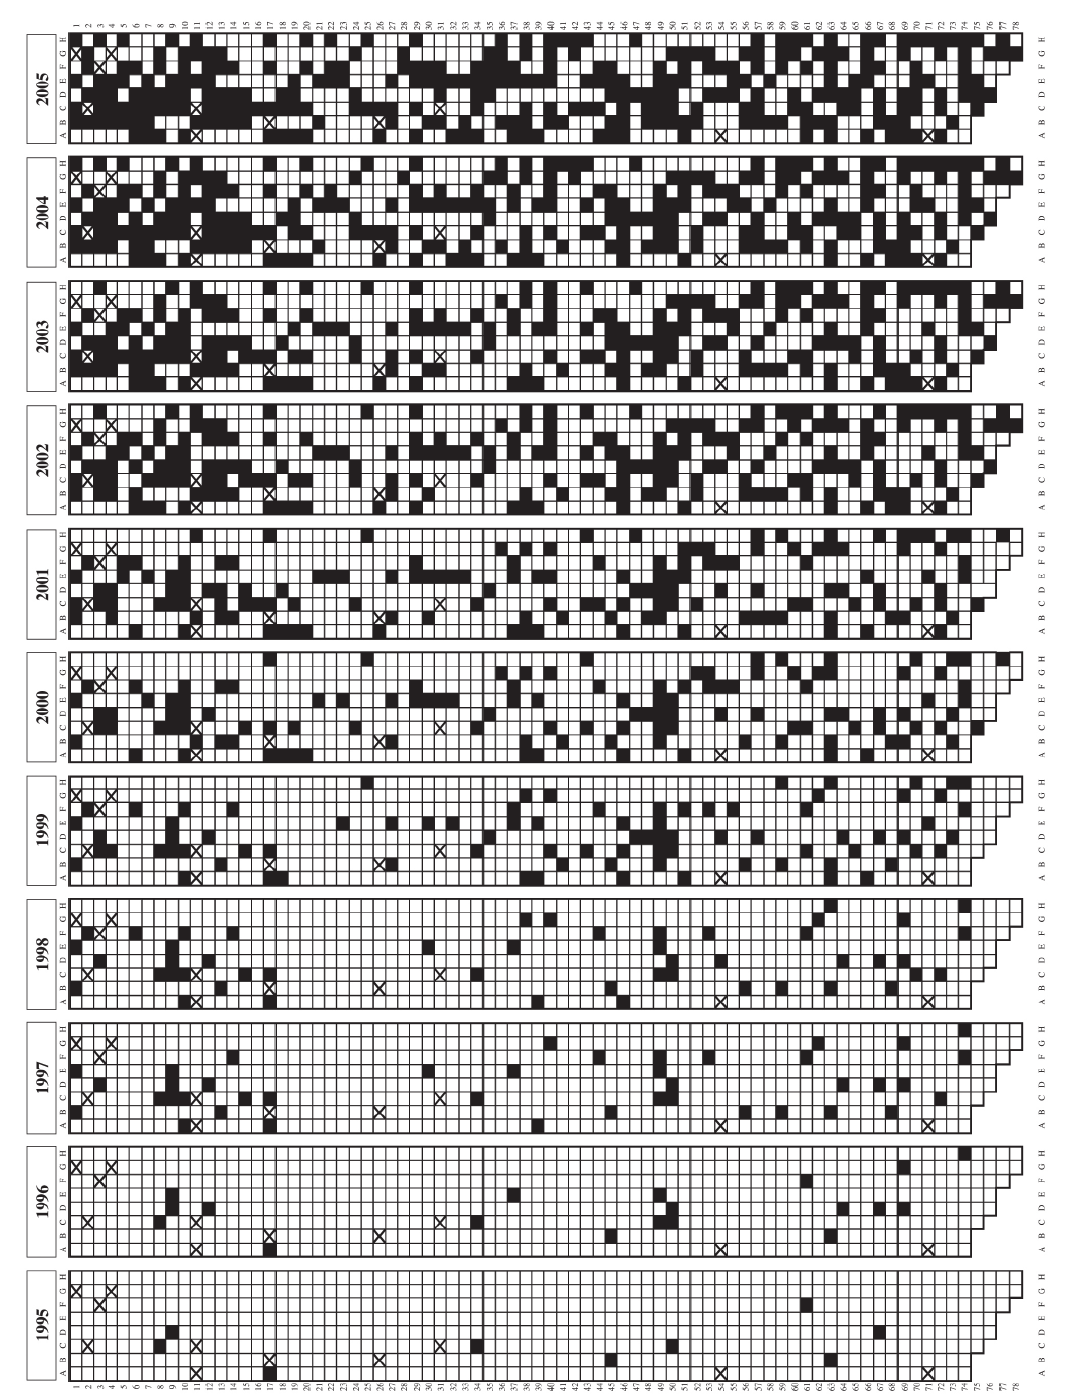
Fig. 8. Spatial pattern of esca-diseased plants in vineyard CBSI4 in the province of Siena. Black squares, sympto- matic plants in current year or in one or more previous years; open squares, asymptomatic plants; ‘ (cid:1) ’, plants died before start of survey (cause